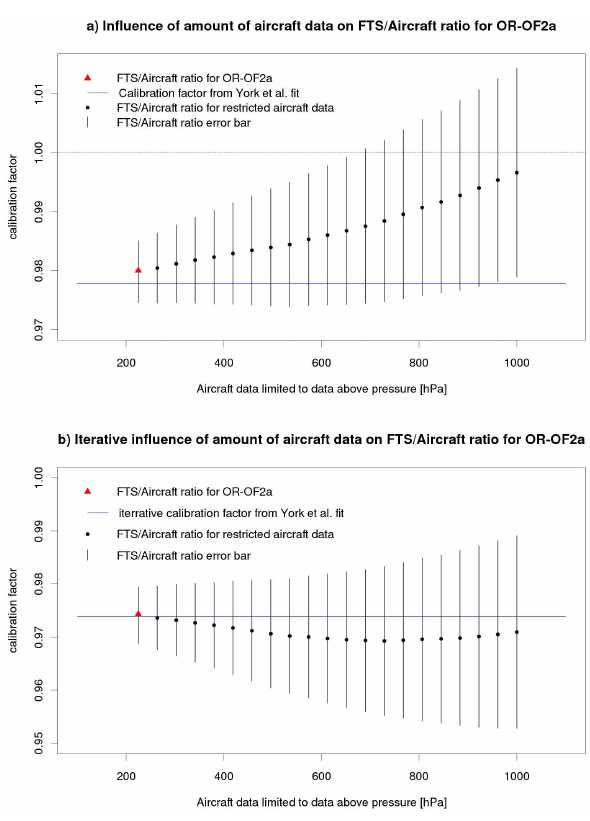
Fig. 11. Illustration of the effect of limited aircraft altitude cover- age on the calibration factor illustraded for the example of overflight OR-OF2a. The red triangle is the (original) FTS-to-aircraft ratio for this overflight while the blue line is the calibration factor determined from all sites (including Wunch et al. (2010) data). Then the verti- cal coverage of the profile is reduced by only including data points with pressure p above a minimum pressure p min ( p > p min ). The black dots show the effect of this reduced vertical coverage on the FTS-to-aircraft ratio for this profile. The error bars are a combina- tion of FTS and aircraft error and increase with reduced vertical coverage. (a) Standard method according to Wunch et al. (2010): with fewer aircraft data the FTS-to-aircraft ratio for this profile ap- proaches one (which would lead to a bias in the calibration factor). (b) New iterative method: the reduced vertical coverage does not lead to a significant bias any more.